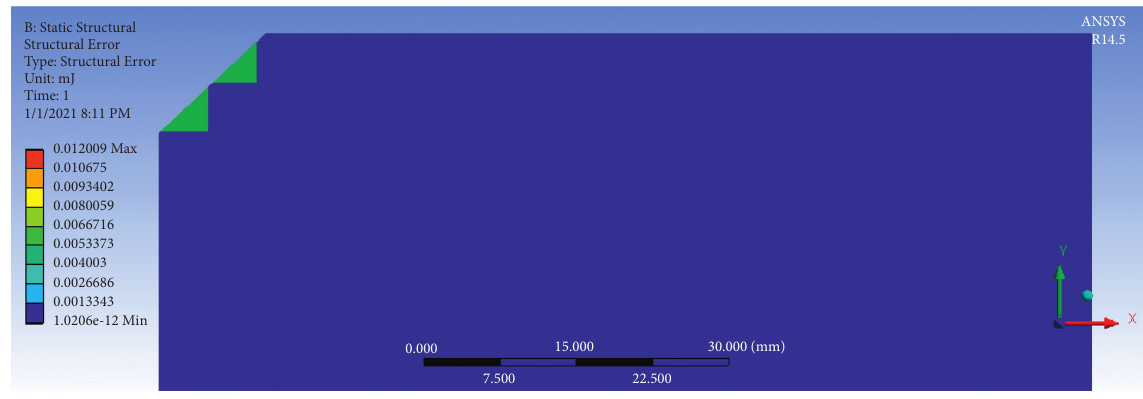
Figure 5: Structural